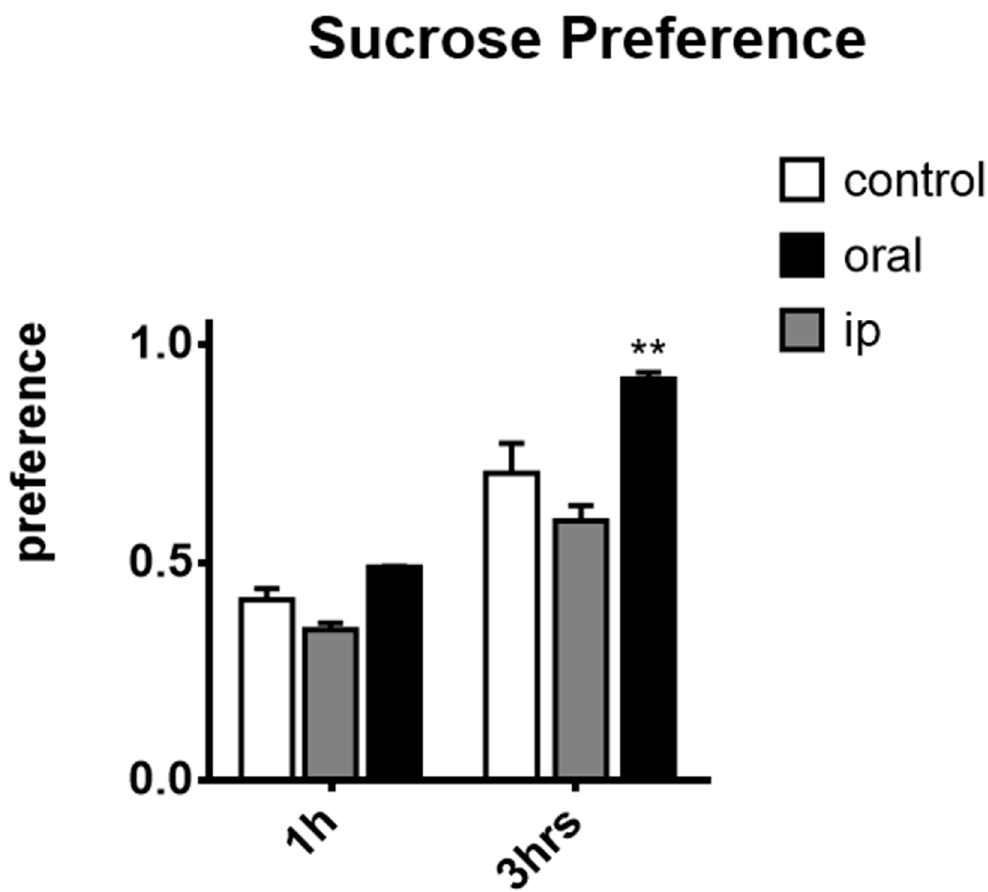
Figure 3. Sucrose preference test. Sucrose preference was calculated as the quantity of sucrose solution drunk/total fluid intake and is considered an index of the motivational state of the animal, ( n = 10 per group) represented as mean ± SEM. Repeated-measures two-way ANOVA with Bonferroni post-hoc test: ** p < 0.001; differences between the oral group and the control group. The tests were administered on day one of treatment and on day 21 for the chronic group, 50 min after drug administration.